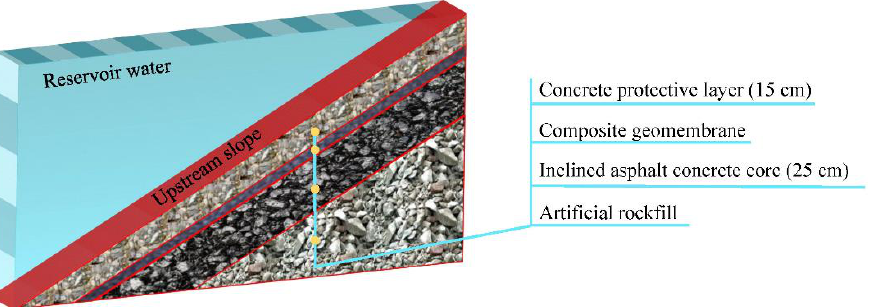
Figure 5. Anti-seepage structure after reinforcement of a blast-fill